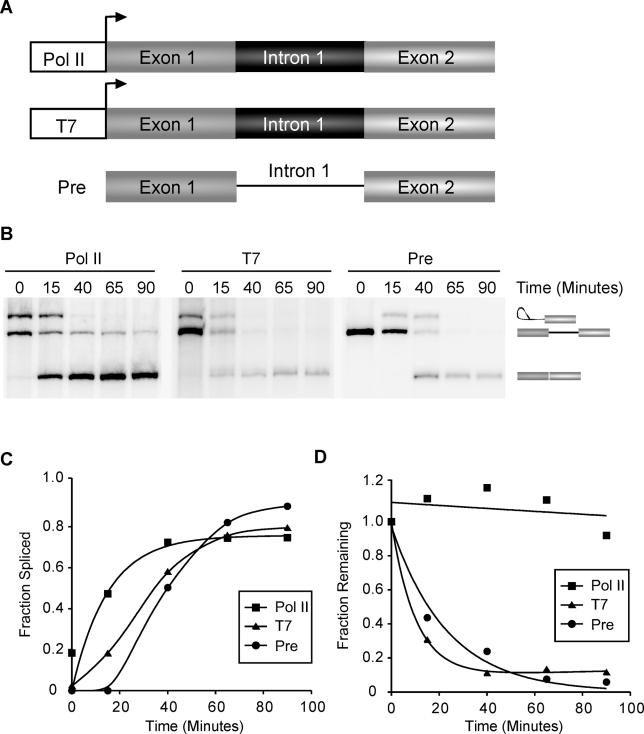
The Link between Pol II Transcription and Splicing Increases the Stability of Nascent Transcripts but Not the Rate of Splicing(A) Diagrams of the wt
β-globin minigene DNA template with the Pol II promoter (top), the T7 promoter (middle), or the pre-synthesized RNA transcript (lower). (B) Representative autoradiograms show the time course of the transcription/splicing UTP chase experiment for Pol II- (left) or T7- (middle) generated transcripts, and the splicing profile of pre-synthesized pre-mRNAs (right). For the transcription/splicing UTP chase experiment, the zero time point refers to the initiation of the chase reaction through the addition of excess unlabeled UTP. Pre-mRNA transcript, spliced product, and intermediate lariat bands are indicated. The pre-synthesized pre-mRNA (right) is capped. (C) Quantitation of the data in (B) by computing the fraction spliced ([lariat] + [product])/ ([lariat] + [product] + [pre-mRNA]). (D) Quantitation of transcript degradation ([lariat] + [product] + [pre-mRNA]).